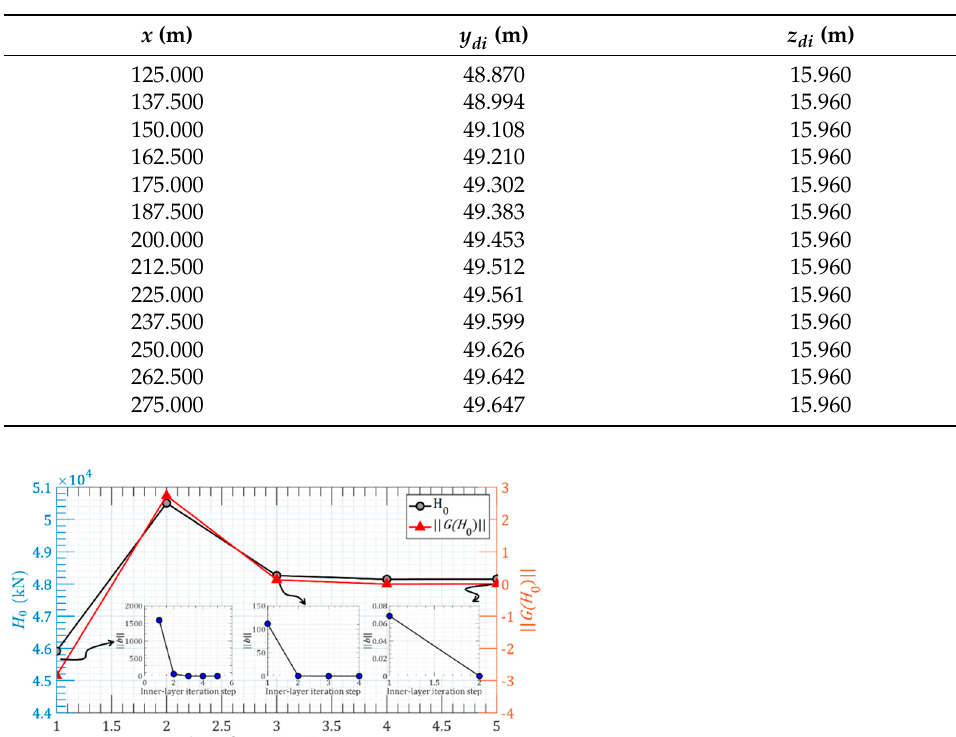
Table 2. Coordinate values of joint points for suspenders and girder.